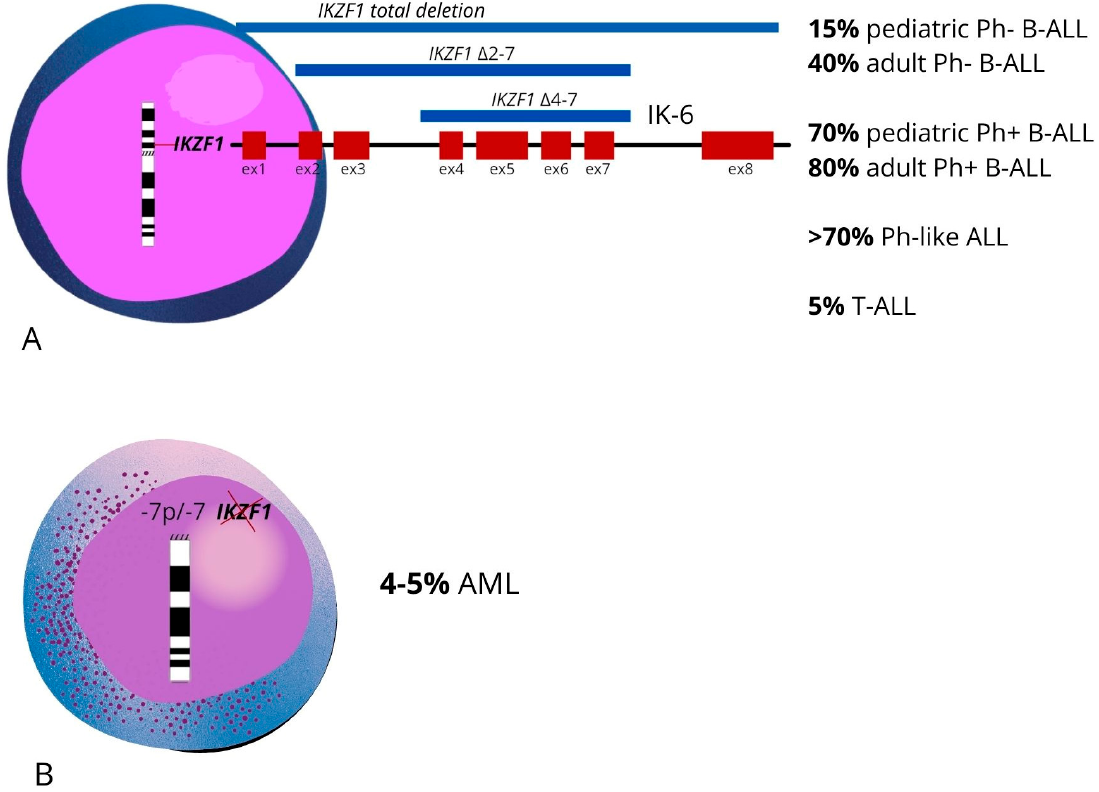
Figure 2. ( A ) Graphic representation of the frequency of the most common IKZF1 alterations in acute lymphoblastic leukemia. ( B ) Graphic representation of the frequency of the most common IKZF1 alterations in acute myeloid leukemia.